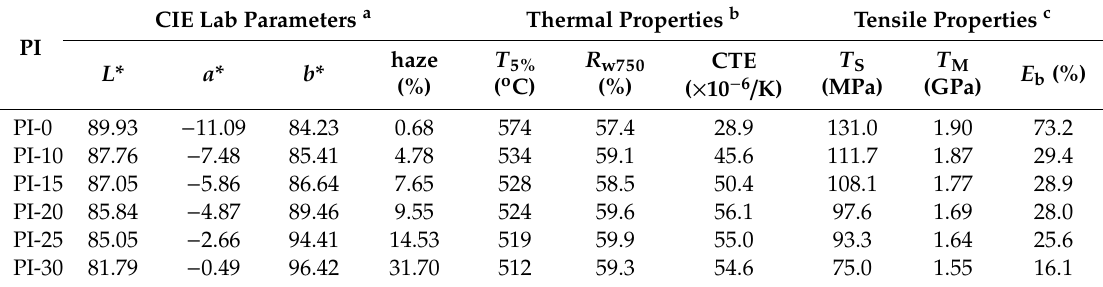
Figure 8. Thermo-gravimetric analysis (TGA) plots of PI films in nitrogen. Figure 8. Thermo ‐ gravimetric analysis (TGA) plots of PI films in nitrogen. Table 2. Optical, thermal, and tensile properties of PI